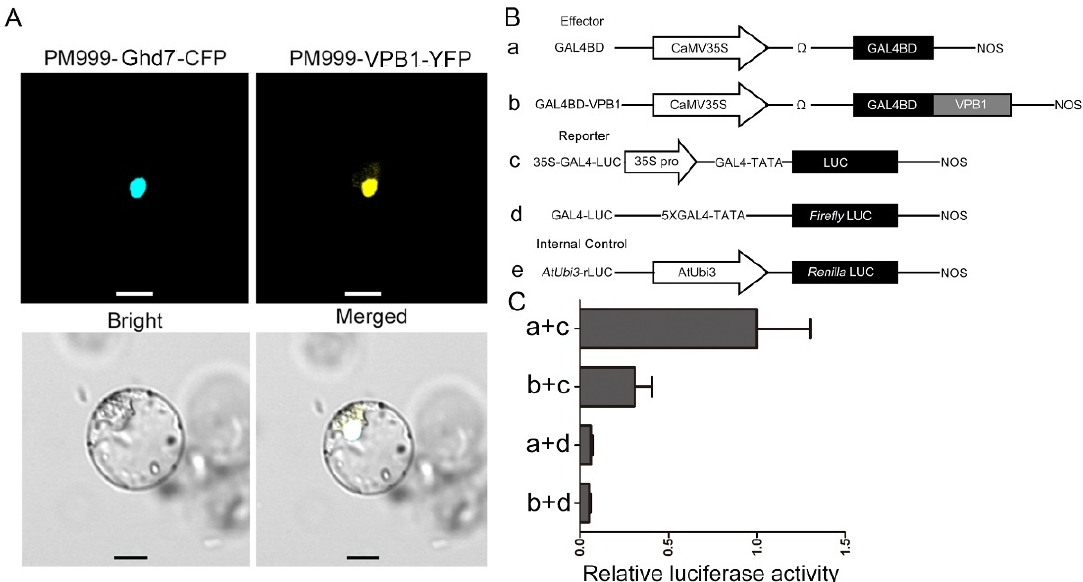
Figure 5. Subcellular localization and transcription activity of VPB1. ( A ) Subcellular localization of VPB1 protein. The VPB1-YFP fusion protein co-localized with the Ghd7 nucleus marker in rice protoplasts. Scale bars, 10 μ m. ( B ) Scheme of the constructs used in the protoplast co-transfection assay. ( C ) Transcriptional activity assay of VPB1 . The activity of 35S-GAL4-LUC and GAL4-LUC was used as the reporter, and rLUC activity was used as an internal control. The fLUC/rLUC ratio represents the relative luciferase activity. Data are mean ± SD ( n = 3 independent replicates).